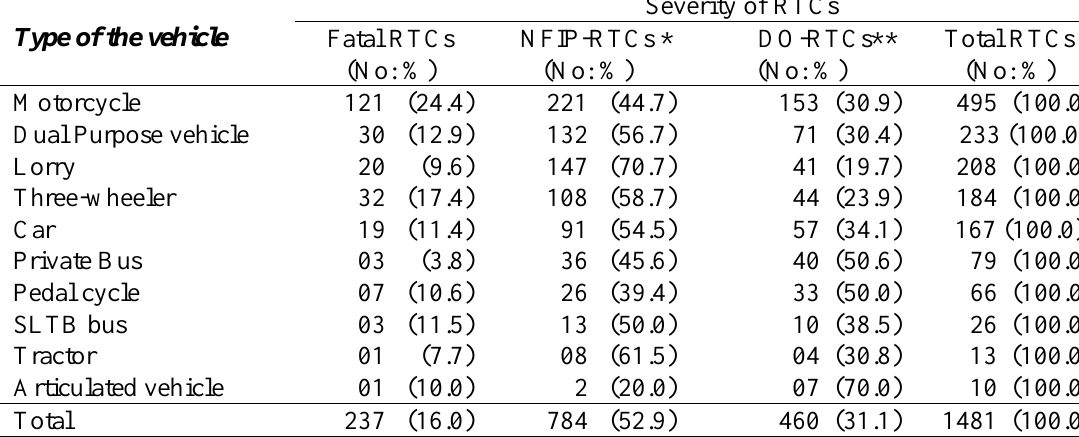
Table 3: Distribution of the severity of RTCs by the type of vehicle in KPD Type of the